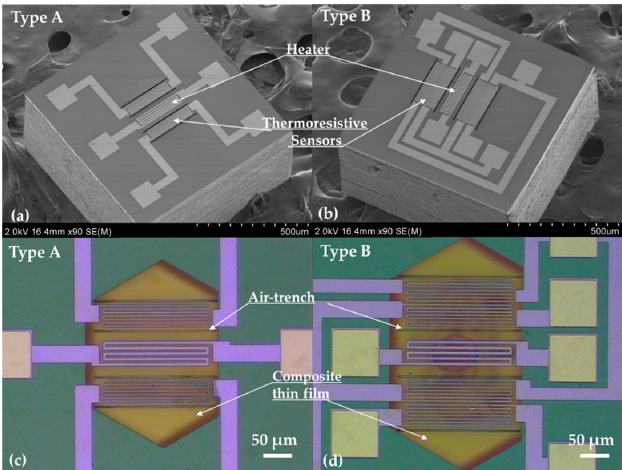
Figure 6. The micrographs showing the fabricated gas flow sensor. ( a , b ) SEM showing the gas flow sensor. ( c , d ) Top-view micrograph image of the gas flow sensor.